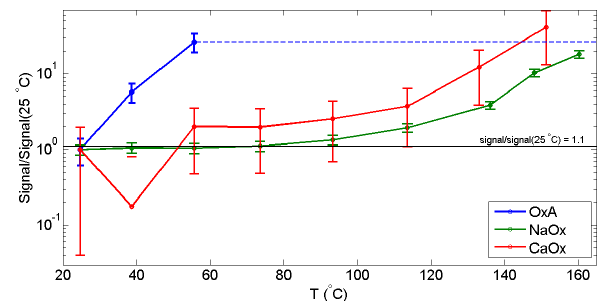
Figure 5. Evaporation of oxalate particles observed with the TPD aerosol-CIMS – natural logarithm of the oxalate signal normalized with the signal at room temperature as a function of inverse mean inlet temperature. Oxalic acid calibration curve (blue), two independent experiments with Na 2 Ox (green) and CaOx along CCN experiment (red) are illustrated in the upper panel. Also the approximate onset temperature of evaporation of oxalate salts is marked (75 ◦ C). In the lower panel the estimation of the ∆ H vap by fitting the data points to Clausius–Clapeyron equation (Eq. 4) above this temperature is shown for Na 2 Ox particles ( Na 2 Ox (1)). Error bars illustrate the standard deviation of the signal from the mean signal. Figure 4. Volatility of Na 2 Ox aerosol with TPD aerosol-CIMS (Na 2 Ox (1)). The detected oxalate signal when aerosol was heated stepwise from room temperature to 160 ◦ C as a function of time 34 (minutes from the beginning of the experiment) is illustrated in the figure (black solid line). Also the average oxalate signal at different temperatures is plotted (blue dots). The average background oxalate signal was subtracted from the oxalate signal for further analysis.